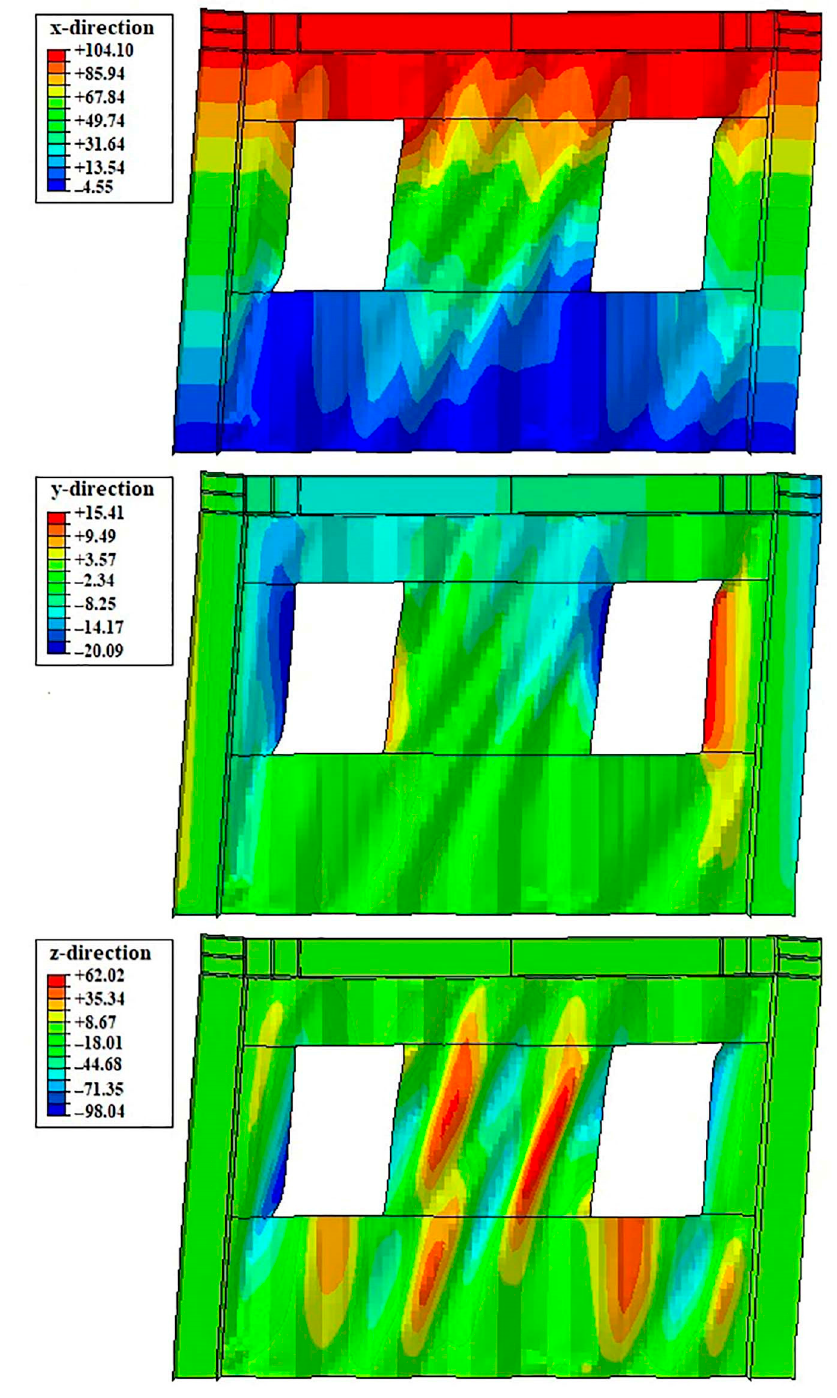
Figure 23. Final deformation form of specimen 2 (mm).